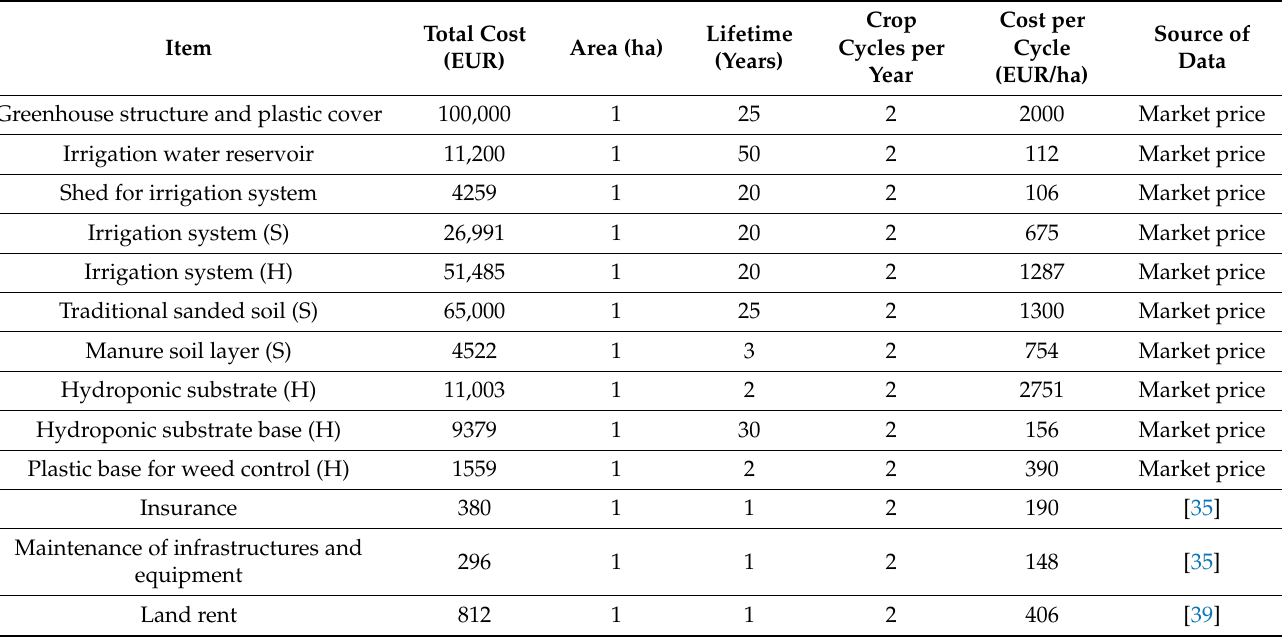
Table 3. Cost of equipment and infrastructures considered in the calculation of indirect